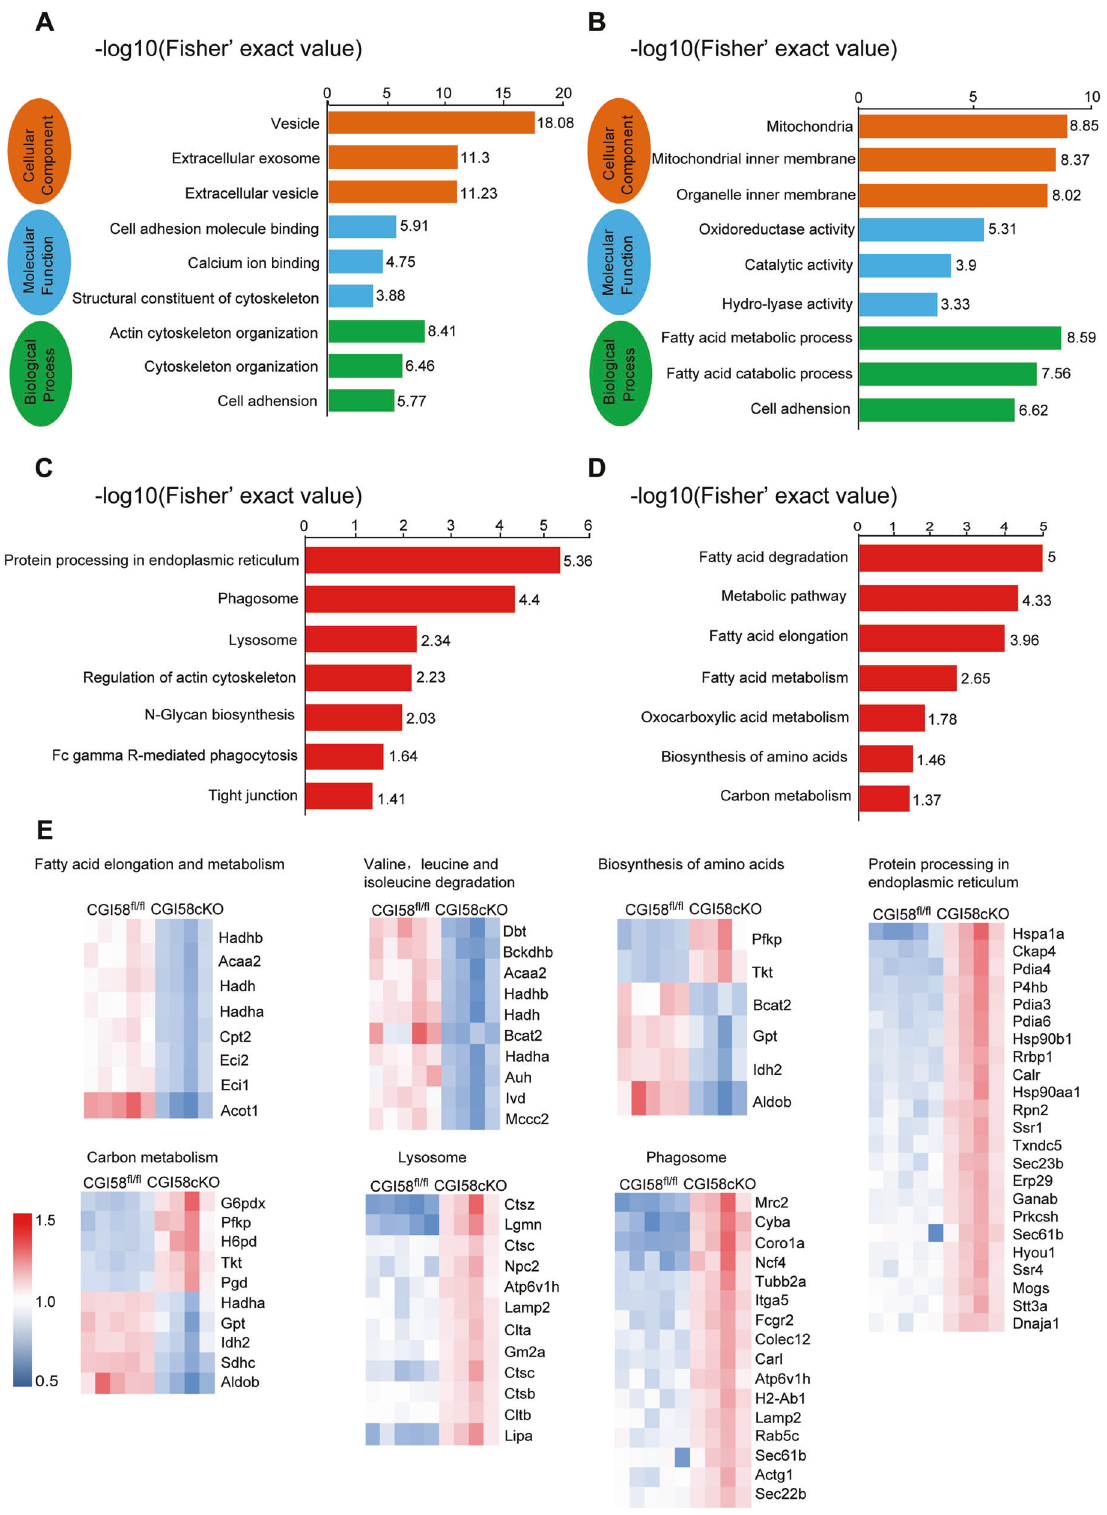
Fig. 4 Proteomic exploration of the biological processes of CGI-58 cko heart. A – D GO and KEGG pathway analysis of the biological processes in the hearts from CGI-58 fl / fl and CGI-58 cko mice. The pathways involved in ER stress, phagosome, lysosome, and fatty acid metabolism are signi fi cantly enriched in CGI-58 cko hearts. The horizontal axis represents − log10 (Fisher ’ exact value); the ordinate represents the GO or KEGG pathway. E The heatmap illustrates the expression level changes of the statistically signi fi cant proteins involved in ER stress, phagosome, lysosome, and fatty acid metabolism between the CGI-58 fl / fl and CGI-58 cko mice.